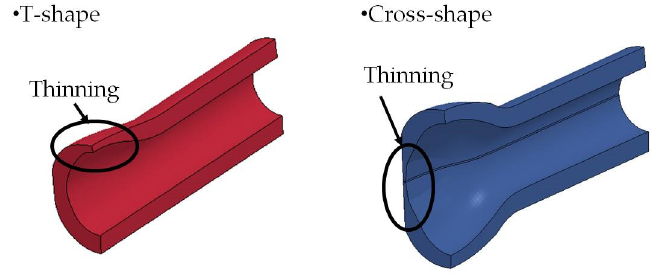
Figure 24. Sections where thinning occurs for T ‐ shape and cross ‐ shape MTHFs.